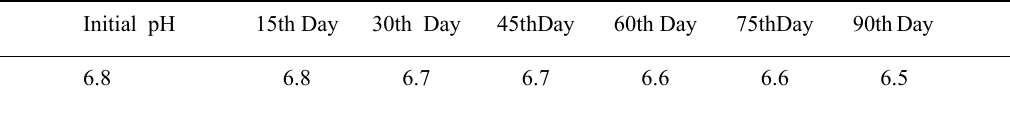
table 3. Variation In